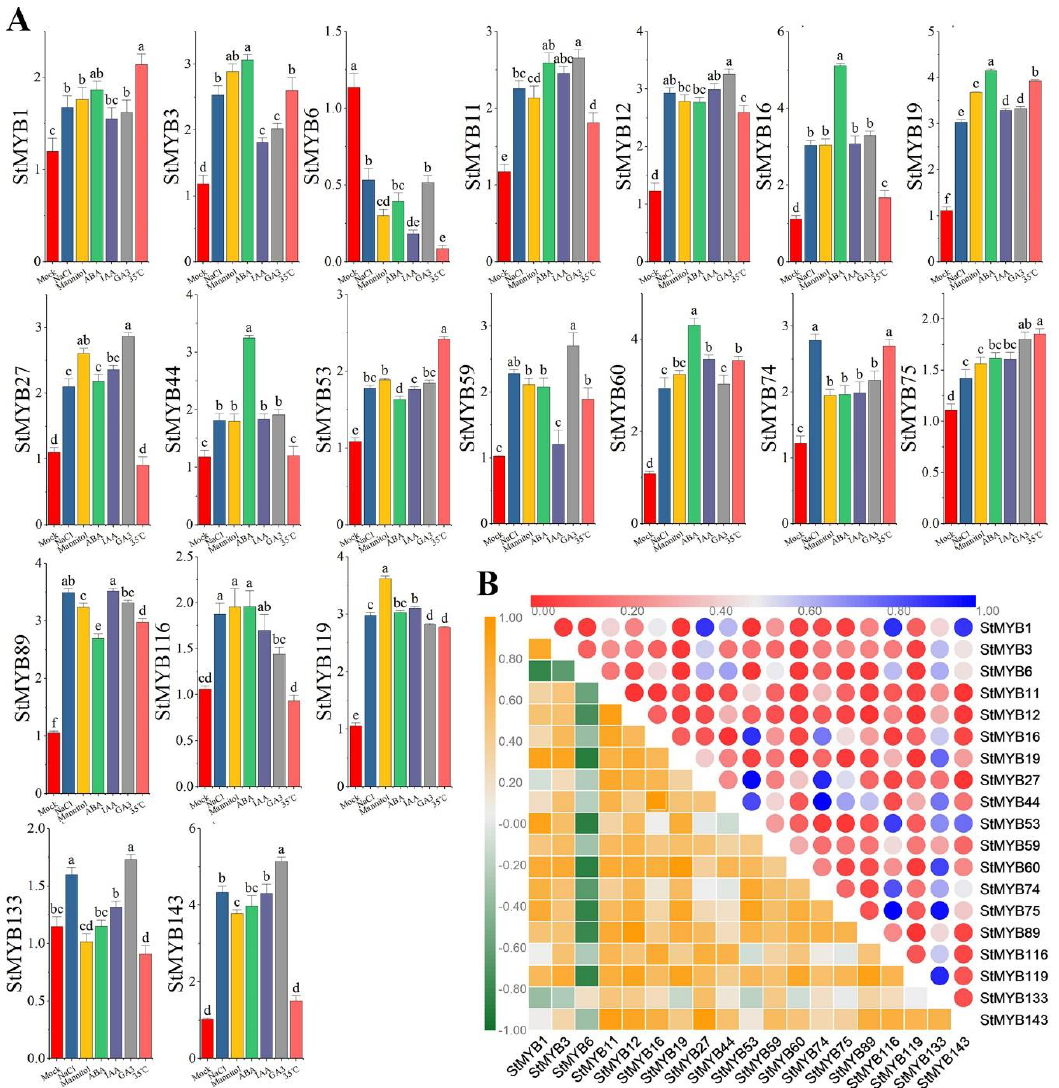
Figure 8. Gene expression of 19 potato MYB genes under hormones and abiotic stress and the correlation between the gene expression patterns of StMYB genes. ( A ) The expression patterns of 19 potato MYB genes under hormones and abiotic stress were examined using a qRT-PCR assay. Error bars were obtained from three measurements. Lowercase letter(s) above the bars indicate significant di ff erences ( α = 0.05, LSD) among the treatments. ( B ) Di ff erent colors represent the correlation of StMYB gene expression patterns under di ff erent hormone and abiotic stress treatments. Di ff erent colors in the lower left corner represent the correlation of StMYB gene expression patterns under di ff erent hormone and abiotic stress treatments, while the di ff erent colors in the upper right corner represent the p -value of the correlation.